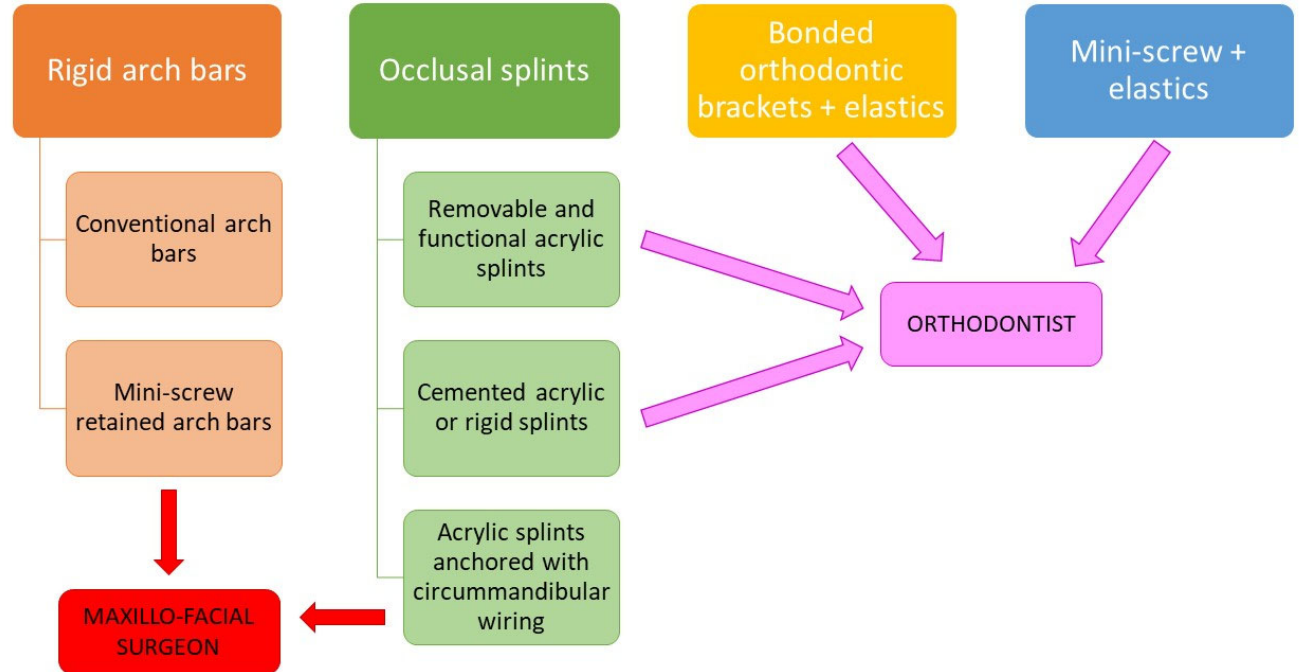
Figure 2. “Closed” approaches for the management of mandibular fractures.